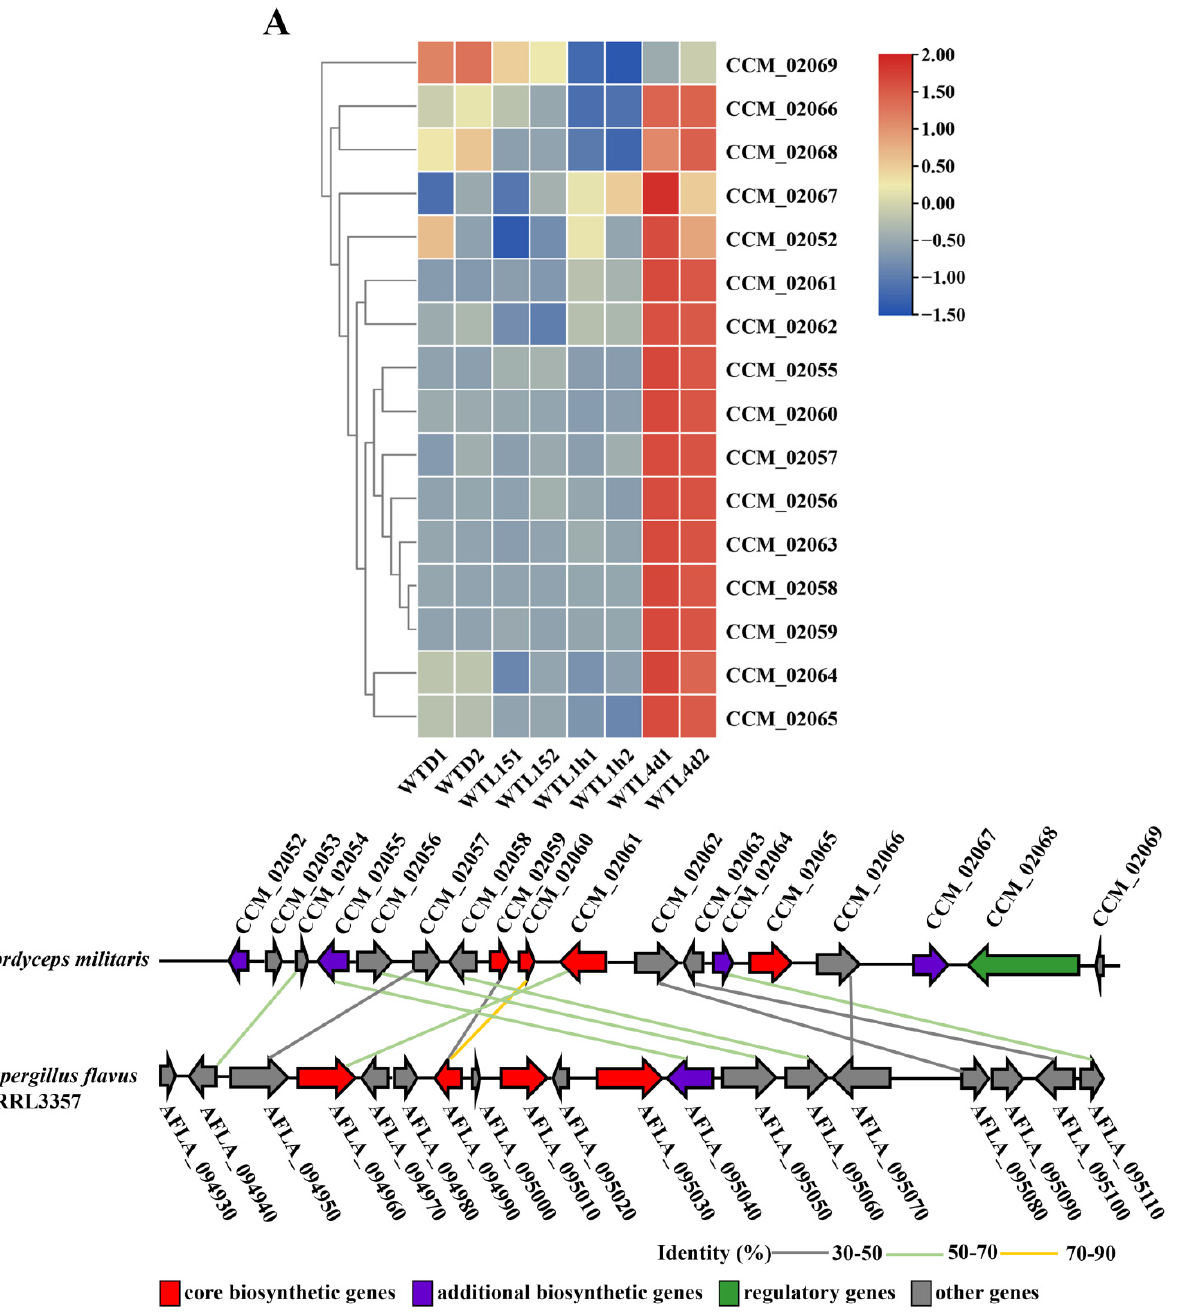
Figure 6. Gene expression and its homolog of the fungal-RIPP gene cluster compared with Aspergillus flavus in Cordyceps militaris . Gene expression of the fungal-RIPP gene cluster ( A ). Synteny analysis of gene cluster is responsible for ustiloxin biosynthesis in Aspergillus flavus and Cordyceps militaris . Horizontal arrows of the same color represent the homologous genes. The sequence identity between the homologous genes from two fungi is shown by bold solid lines with different colors ( B ).